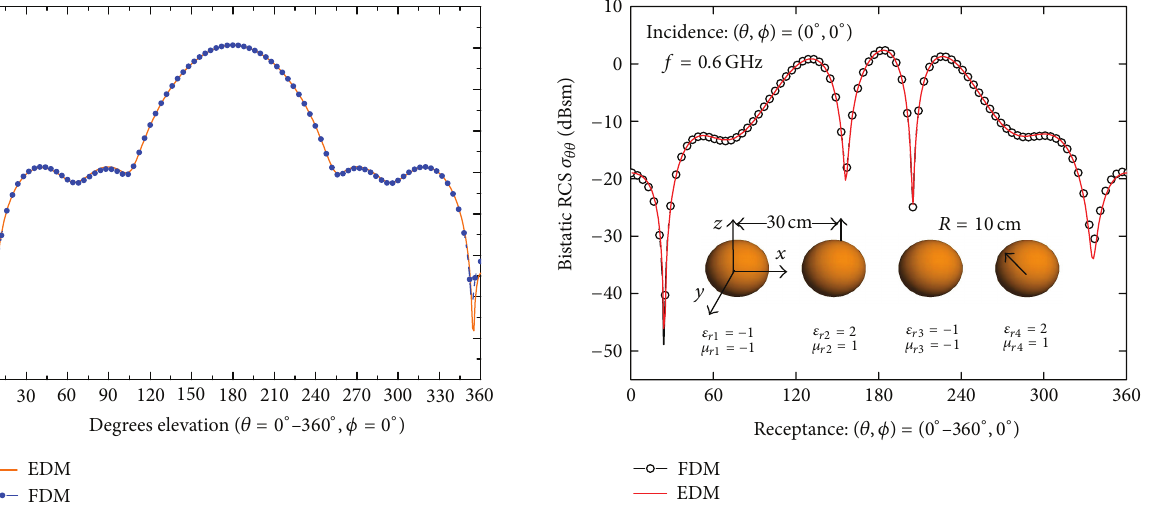
Figure 1: Bistatic RCSs ( 𝜃𝜃 polarization) of a thin plate with 1.0 m × 1.0 m × 0.05 m and 𝜀 the incident direction of (𝜃,𝜙) = (0 ∘ , 0 ∘ ) at 0.3 GHz.